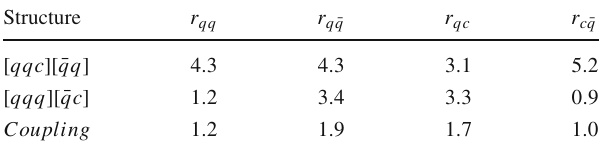
Table 16 The RMS distances of the qqq ¯ qc pentaquark system